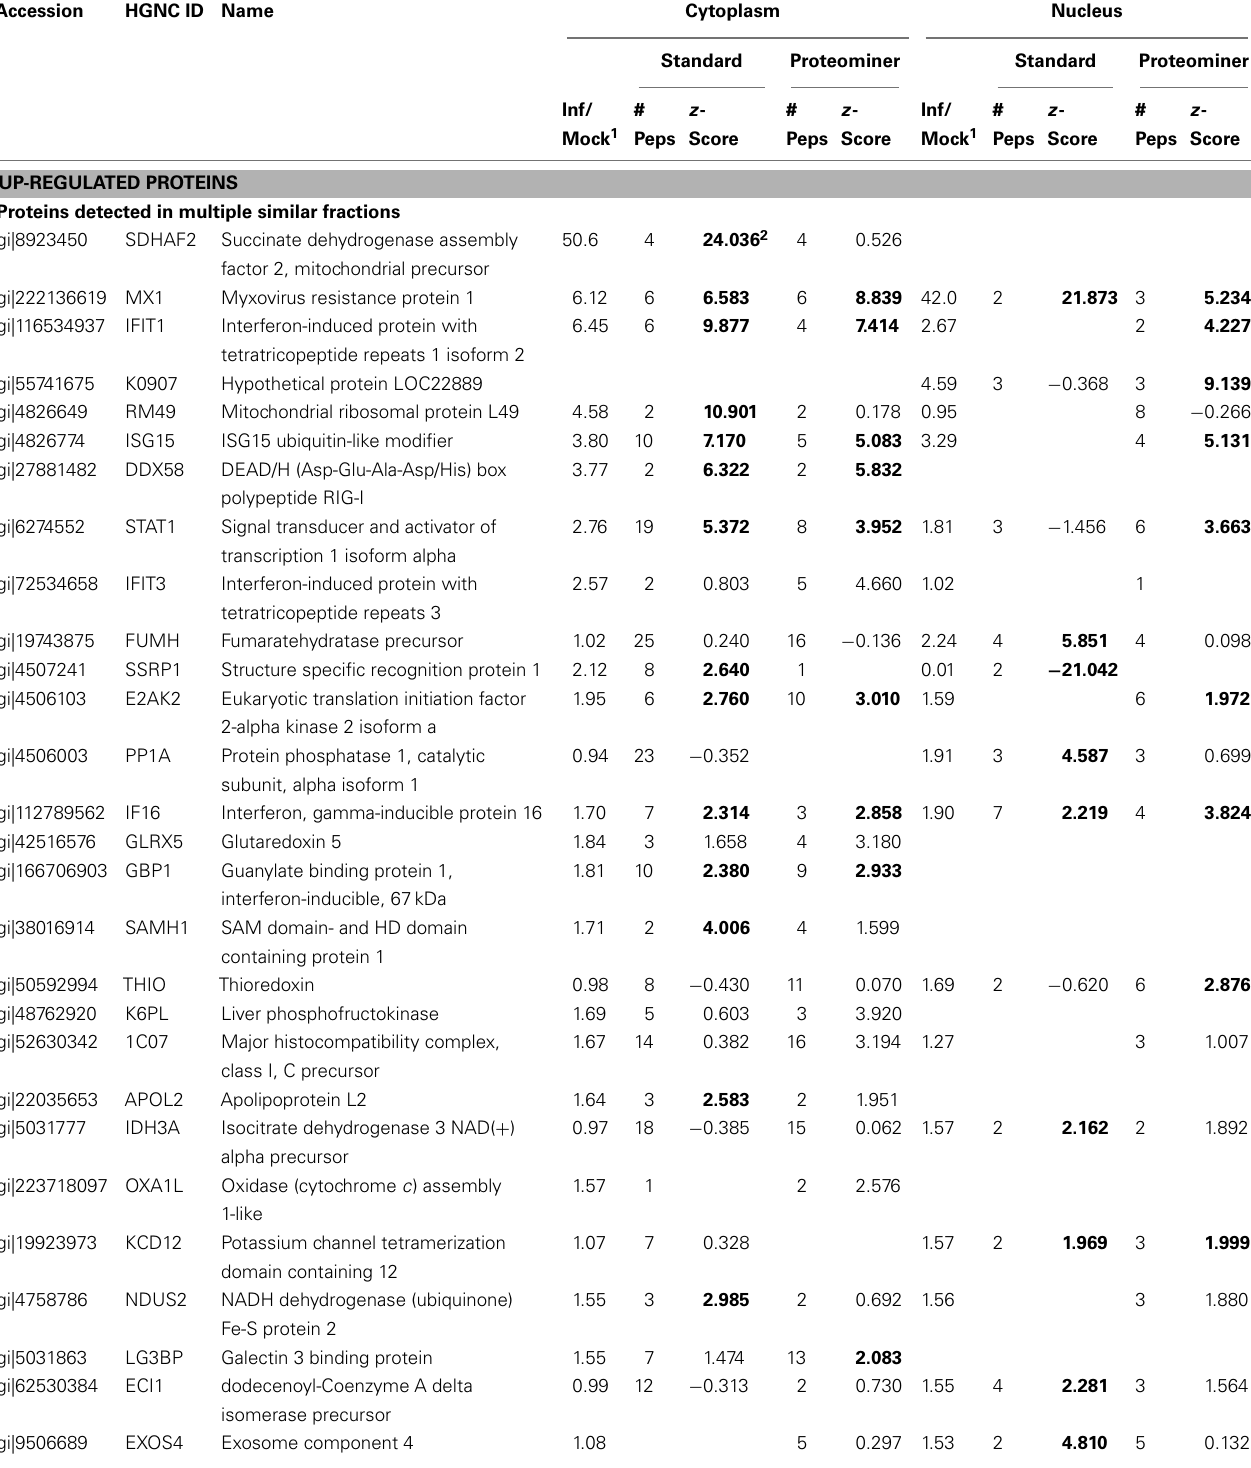
Table 2 | Significantly affected HeLa cell proteins after reovirus